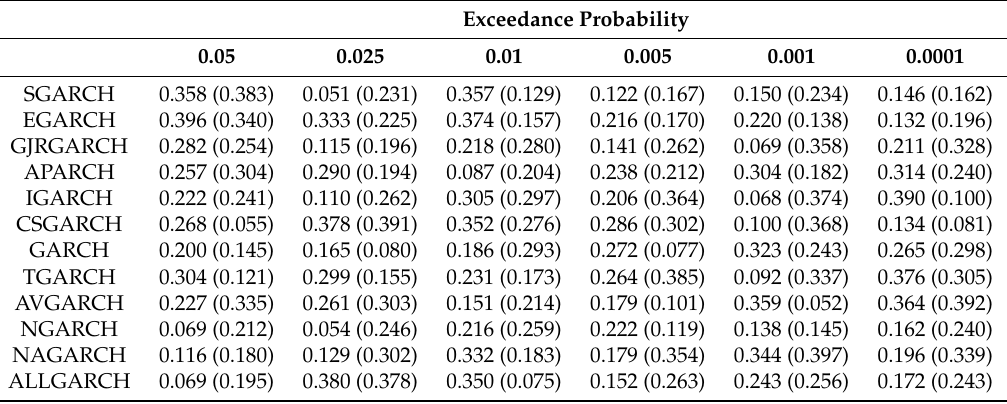
Table 3. p -values of the unconditional (conditional) coverage value at risk exceedance test for the log returns of the exchange rates of Dash from 22 June 2014–17 May